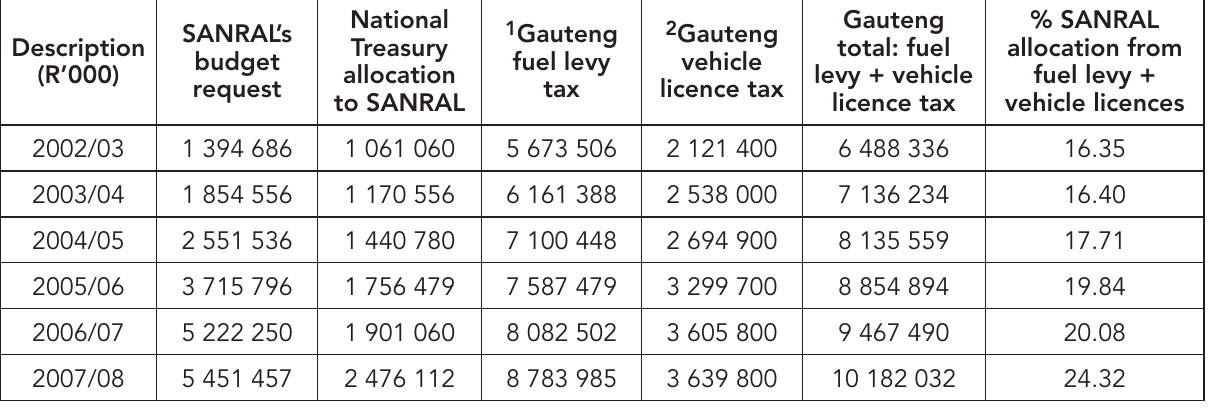
Table II: National Treasury allocation to SANRAL